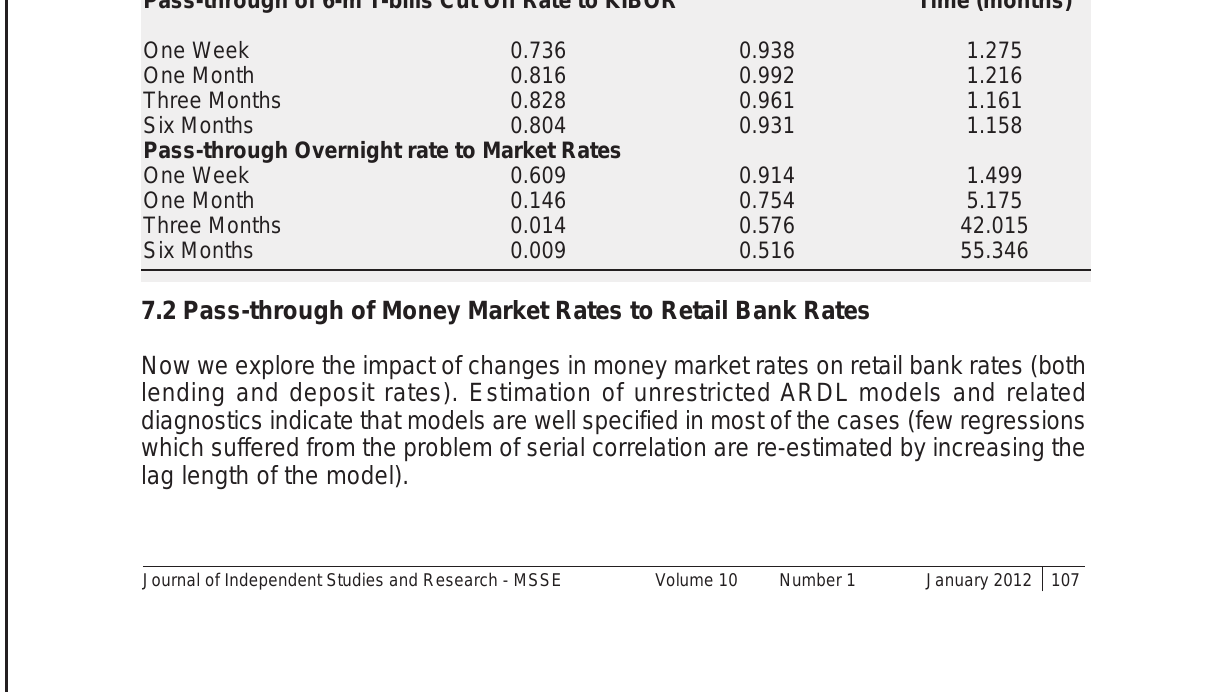
Table 5: Pass-through of Policy Rates to Money Market Rates Short Run Long Run Approximate Pass-through of 6-m T-bills Cut Off Rate to KIBOR Time